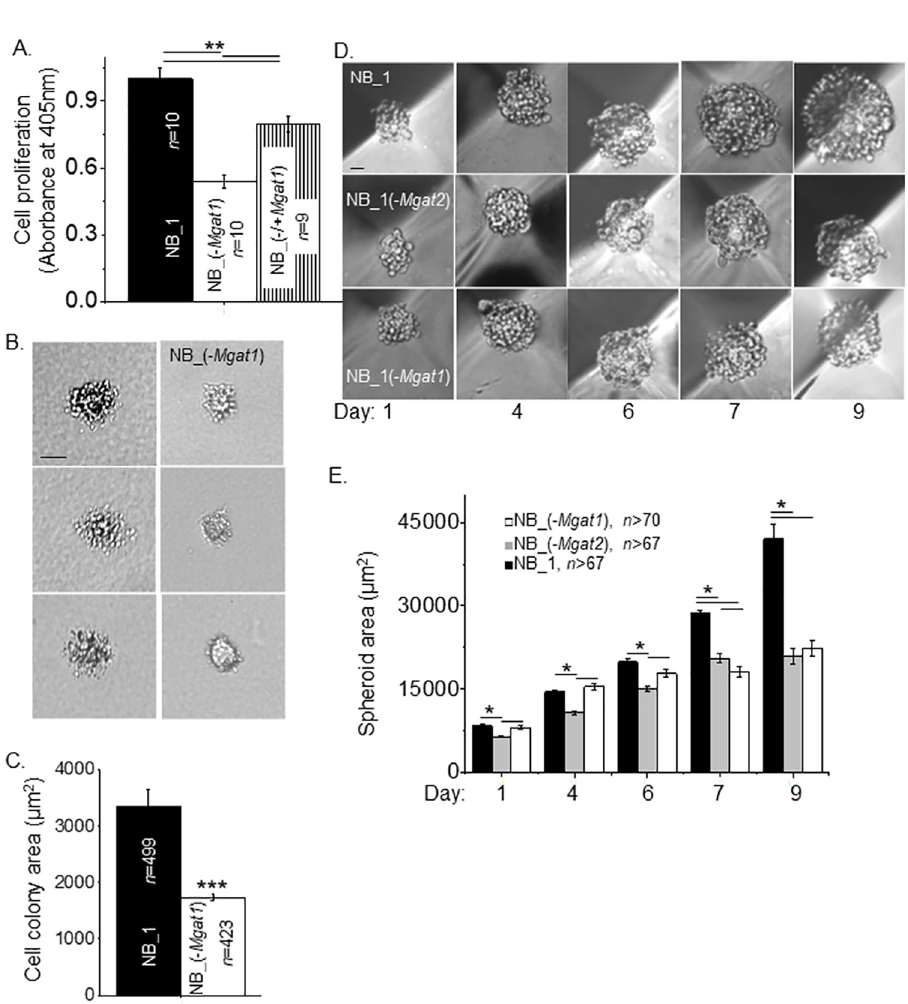
Fig 3. Diminution of N-glycan diversity alters NB cell growth and spheroid formation. (A) Cell proliferation of NB_1 and NB_(- Mgat1 ) cell lines from 2D cell cultures, and the rescued cell line, NB_(-/+ Mgat1 ). (B) Images of growing cell colonies obtained from anchorage independent cell growth of NB_1 and NB_(- Mgat1 ) cell lines. (C) Quantification of the size of cell colonies after 13 days of growth. (D) Representative images of spheroid formation in NB cell lines at various time points were obtained at 10x magnification. (E) Quantification of spheroid growth from 1 to 9 days in culture. Pearson’s correlation coefficient of the spheroid area as a function of days for NB_1, NB_1 (- Mgat2 ) and NB_(- Mgat1 ) were 0.99, 0.99, and 0.94, respectively. Growth rates were (in area/days): 10,130, NB_1; 6,625, NB_1(- Mgat2 ); and 6,036, NB_1(- Mgat1 ). Scale bars are 25 μ m. Data are presented as the mean ± SEM and were compared by one-way ANOVA followed by Bonholm adjustment for more than 2 groups and student t-test for 2 groups, ( � p < 0.05, �� p < 0.005, ��� p < 1 x10 -6 ). n signifies number of wells ( A ), cell clusters ( C ), and spheroids ( E ). Images of cell colony size under anchorage independent cell growth conditions for 13 days were reduced in the glycosylation mutant cell line compared to the parental cell line (Fig 3B). Quantification of cell colony area between NB_1 and NB_1(- Mgat1 ) cell lines revealed close to a 52% difference in cell growth (Fig 3C). Lastly, cell growth was observed at 1, 4, 6, 7 and 9 days for NB_1, NB_1(- Mgat1 ) and NB_1(- Mgat2 ) cell lines using 5D spherical plates (Fig 3D). Spheroid cell size of NB_1 and NB_1(- Mgat1 ) cell lines were similar up to 6 days while the spheroids of NB_1(- Mgat2 ) cells were slightly smaller (Fig 3E). Though the spheroid size of NB_1(- Mgat2 ) cells was larger than that of NB_1(- Mgat1 ) cells at day 7 and also the spheroid from NB_1 cells continued to be the largest. The growth rates were (in spheroid area/days):